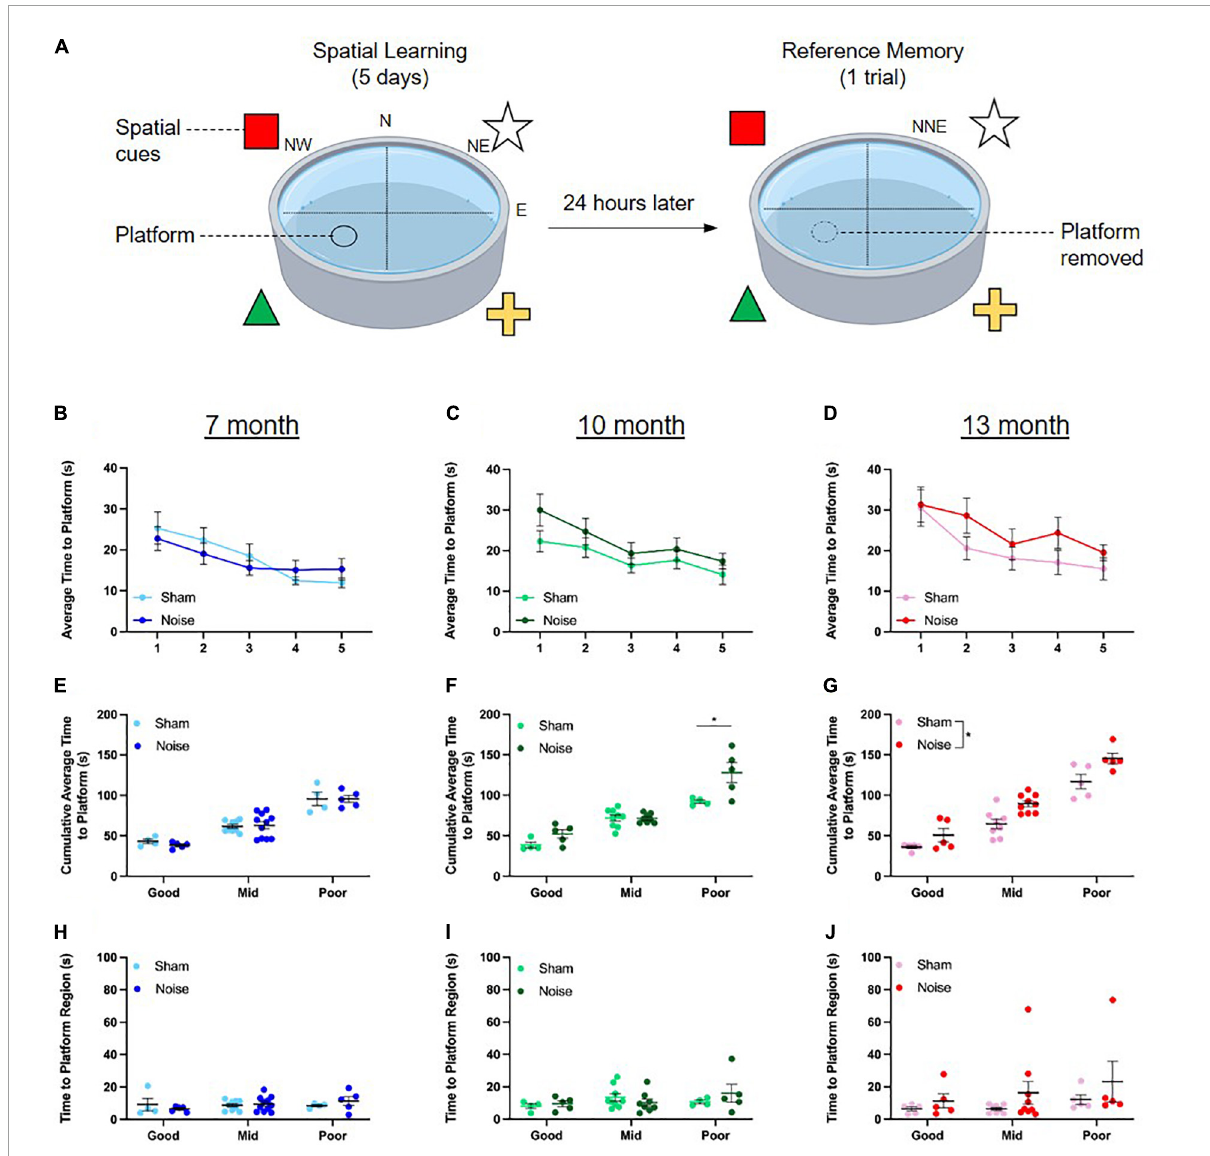
FIGURE3 Hippocampal-dependent spatial learning was impaired in noise-exposed 13-month-old rats and a subset of noise-exposed 10-month-old rats. (A) During the spatial learning component of the Morris water maze task, rats underwent 4 trials/day for 5 days, utilizing extra-maze visual cues placed on the wall to locate a submerged platform in the pool. On each day, rats were released facing the pool wall in the NW, N, NE, and E positions for trials 1–4, respectively. On the 6th day, rats were placed in the NNE location and underwent one trial to assess their reference memory during which the platform was removed. (B–D) Rats demonstrated spatial learning, as evidenced by improved performance on the task over the 5 days of testing. There were no significant differences in the learning curves between noise- and sham-exposed rats at any age. (E,F) While noise exposure had no effect on the cumulative time to reach the platform at 7 months of age, spatial learning was impaired in the poorly performing noise-exposed rats at 10 months of age (* p bonf < 0.05). (G) By 13 months of age, noise exposure impaired spatial learning, regardless of performance type (significant main effect of treatment, * p < 0.05). (H–J) At all ages, reference memory was unaffected by noise exposure. n = 7-month (Sham: 9 male, 8 female; Noise: 9 male, 12 female), 10-month (Sham: 9 male, 8 female; Noise: 9 male, 9 female), and 13-month (Sham: 10 male, 8 female; Noise: 10 male, 9 female). Data represent group mean ±